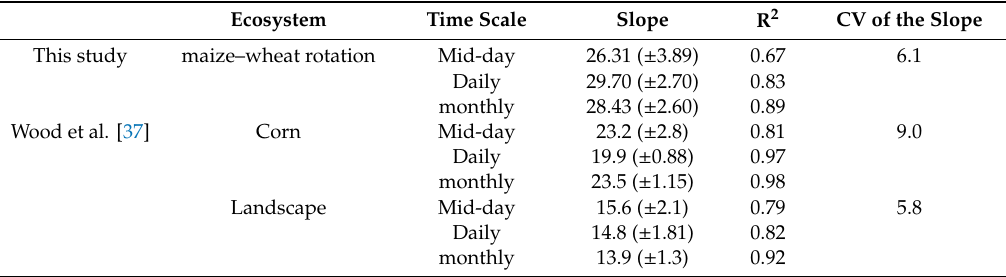
Table 5. The slope, R 2 , and the coe ffi cients of variation (CV = standard deviations / mean × 100%) of the linear GPP–SIF model in this study, from Wood et al.